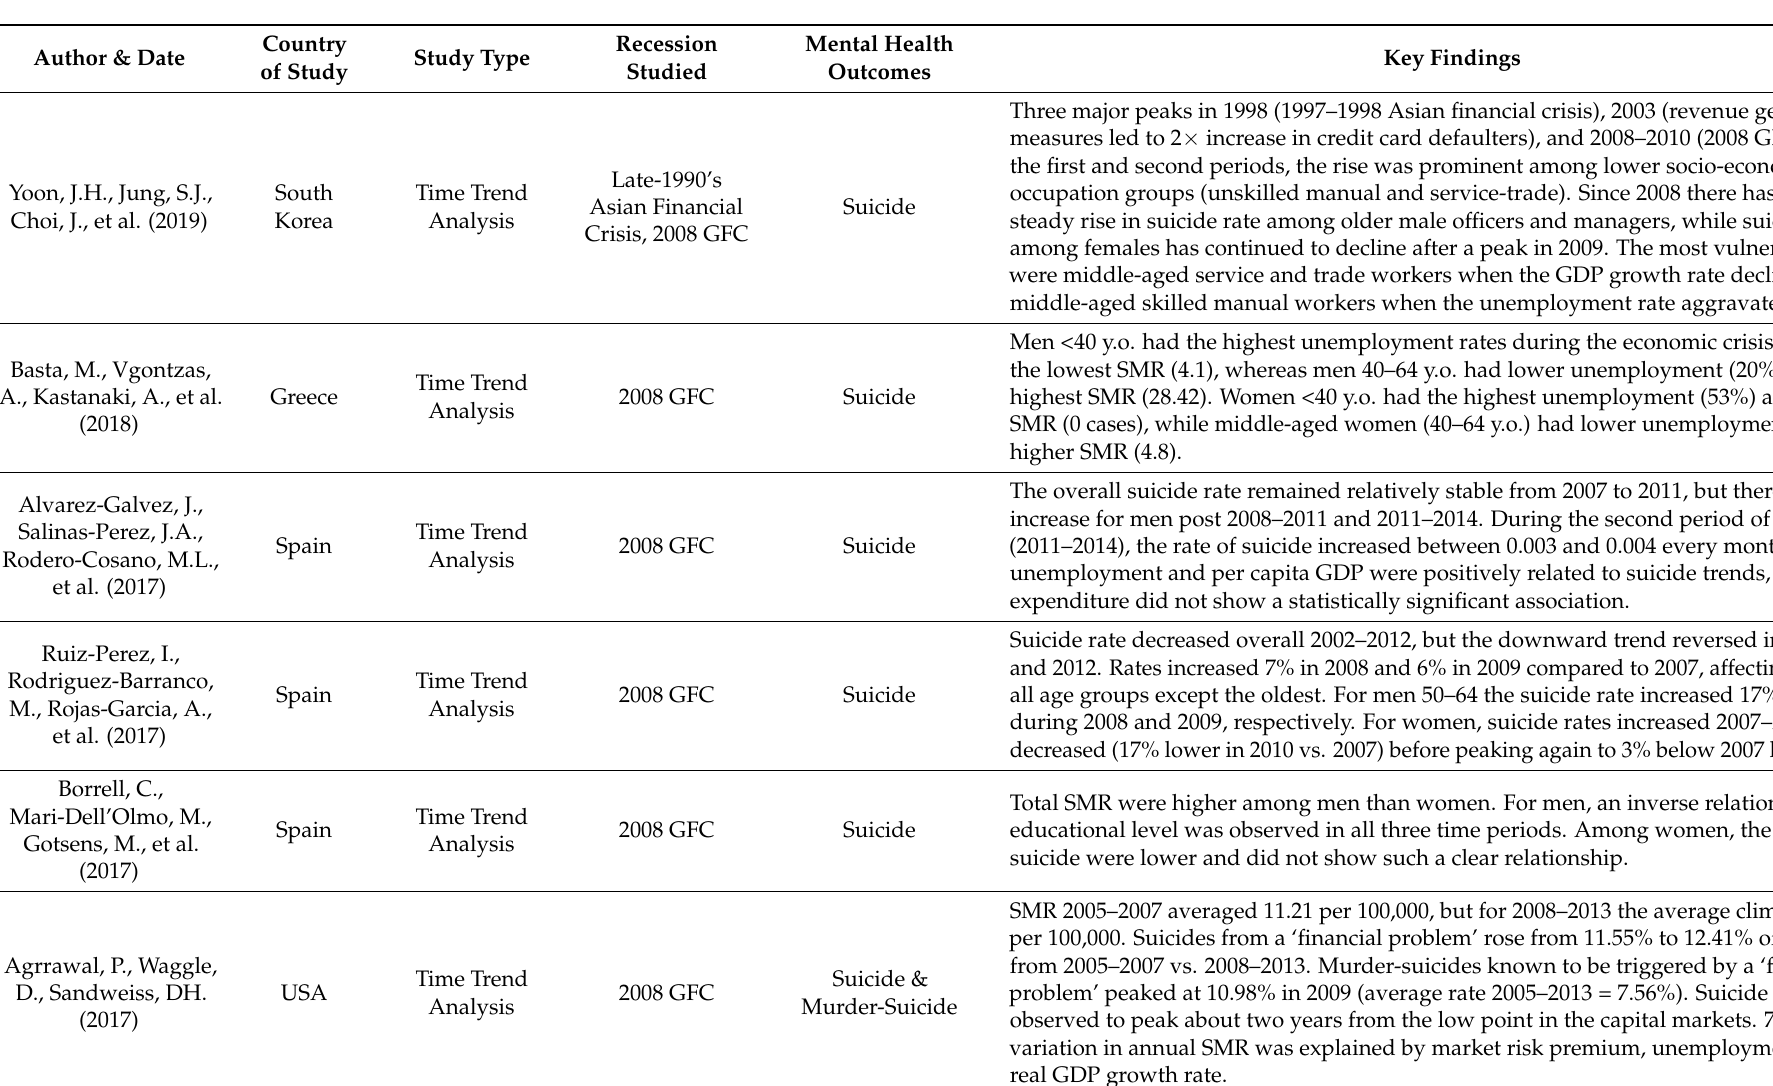
the first and second periods, the rise was prominent among lower socio-economic occupation groups (unskilled manual and service-trade). Since 2008 there has been a